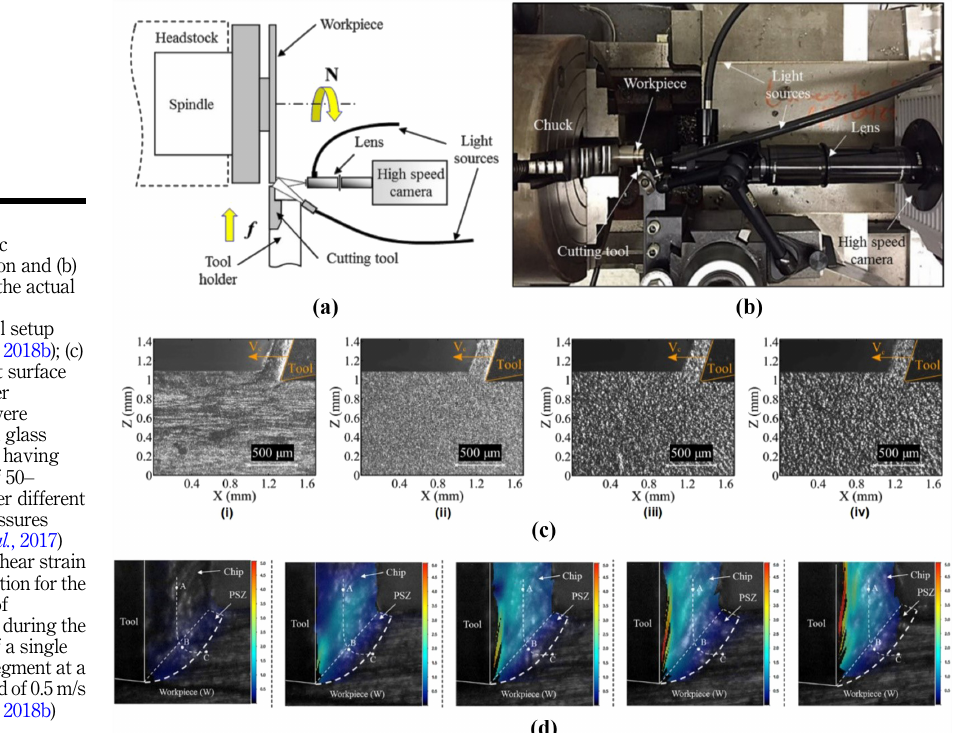
Figure 6. (a) Schematic representation and (b) top view of the actual imaging of experimental setup (Davis et al. , 2018b); (c) the resultant surface textures after specimens were blasted with glass micro-beads having diameters of 50 – 100 μ m under different blasting pressures (Baizeau et al. , 2017) and (d) the shear strain rate distribution for the five stages of deformation during the formation of a single saw-tooth segment at a cuttingspeedof0.5 m/s (Davis et al. ,